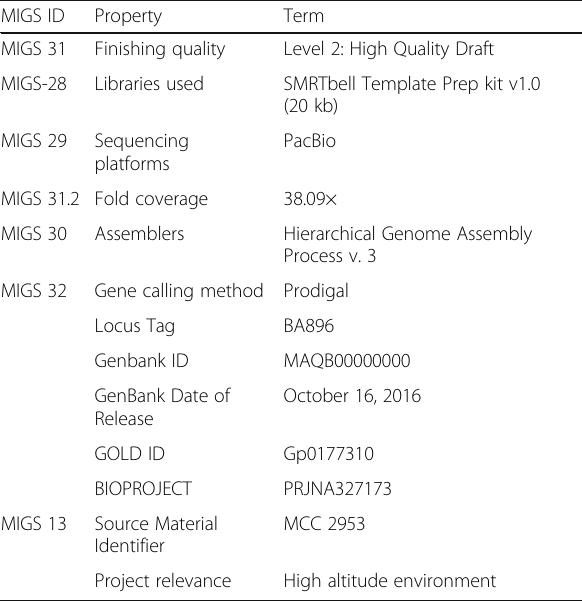
Table 2 Project information